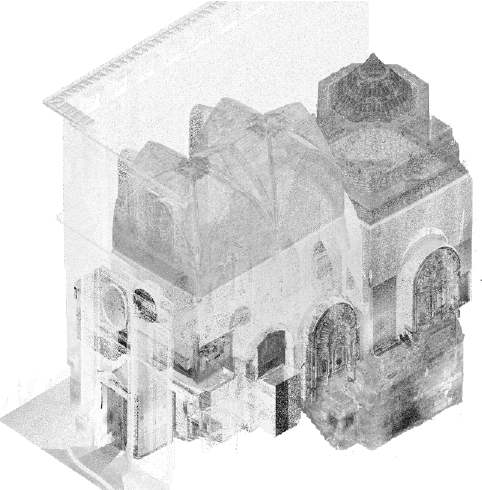
Figure 8 . Point cloud digital model of the Chapel of San Miguel.